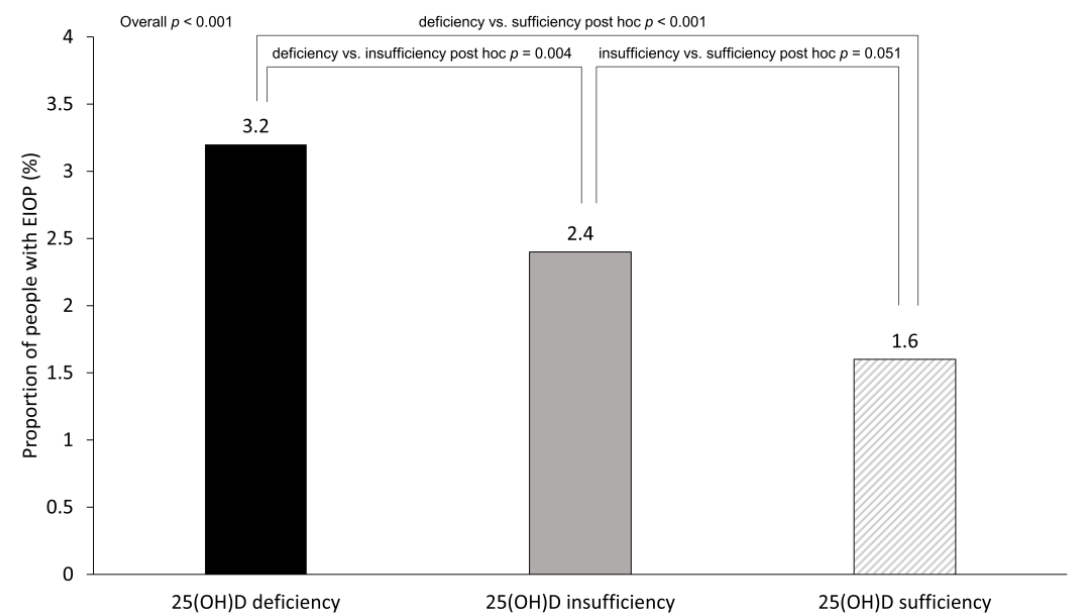
Figure 2. The proportion of people with EIOP according to 25(OH)D status. Chi-square tests were used to compare differences in the proportion of people with EIOP among groups. Pairwise comparison tests were completed. A p -value < 0.05 was considered statistically significant. Abbreviation: 25(OH)D, 25-hydroxyvitamin D; EIOP, elevated intraocular pressure. A cubic spline curve revealed a significant inverse relationship between serum 25(OH)D levels and the OR for EIOP (Figure 3). As serum 25(OH)D level increased, the risk of EIOP decreased (overall p <